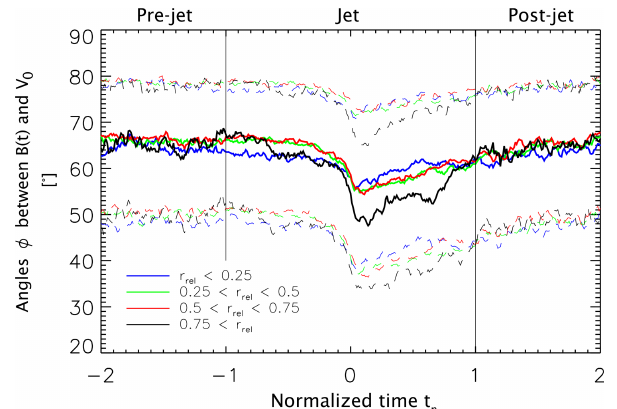
Figure 6. Superposed epoch analyses of the angle φ B , V tion of the relative location of jet observations between the magne- topause ( r rel = 0) and the bow shock ( r rel = 1). As in Fig. 3, solid lines show median values and dashed lines show upper and lower quartiles.